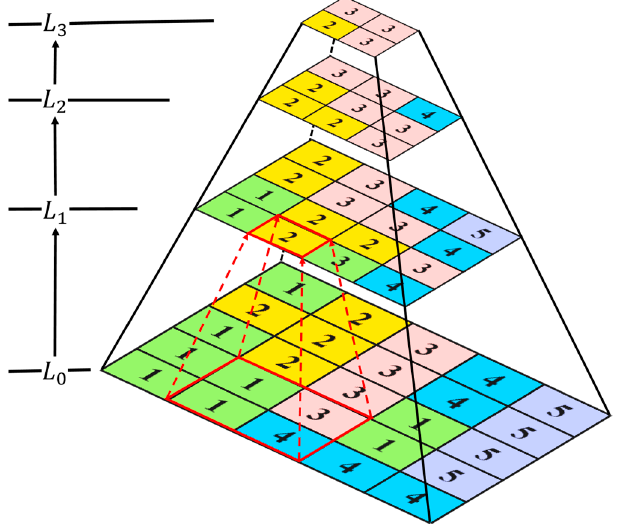
Figure 9. Downsampling with mean filtering to generate image pyramid.